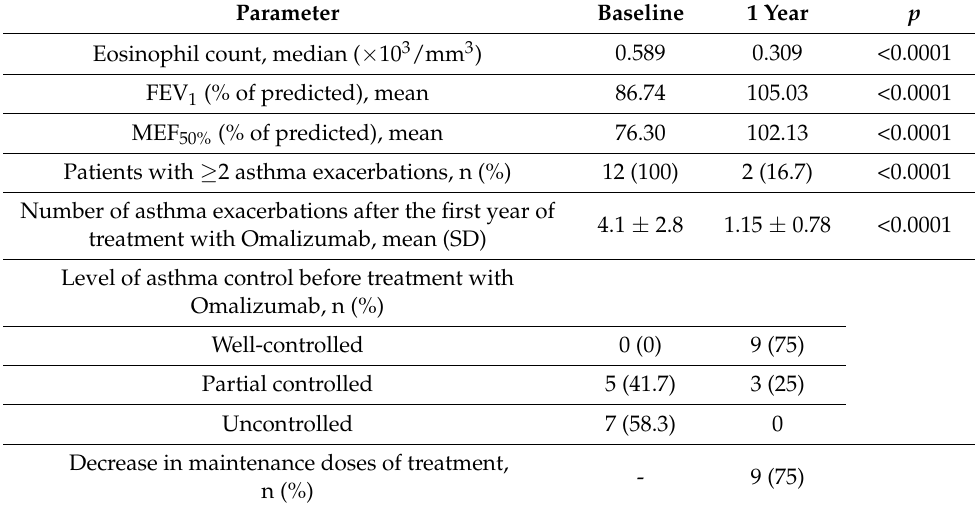
Table 2. The effects on children and adolescents with severe asthma of one year of treatment with Omalizumab. Parameter Baseline 1 Year p Eosinophil count, median ( × 10 3 /mm 3 ) 0.589 0.309 <0.0001 FEV 1 (% of predicted), mean 86.74 105.03 <0.0001 MEF 50% (% of predicted), mean 76.30 102.13 <0.0001 Patients with ≥ 2 asthma exacerbations, n (%) 12 (100) 2 (16.7) <0.0001 4.1 ± 2.8 1.15 ± 0.78